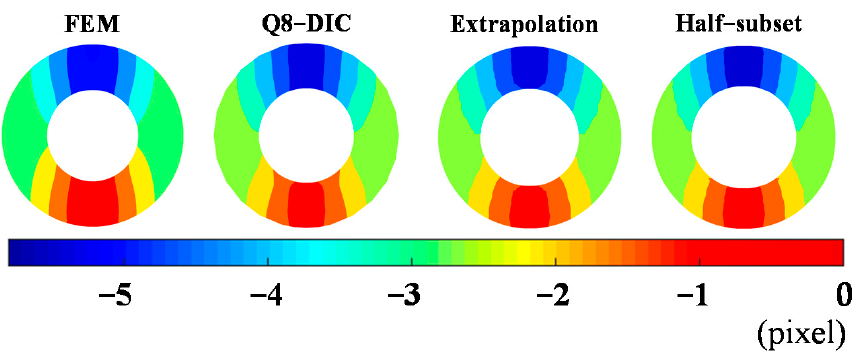
Figure 14. Displacement fields using different